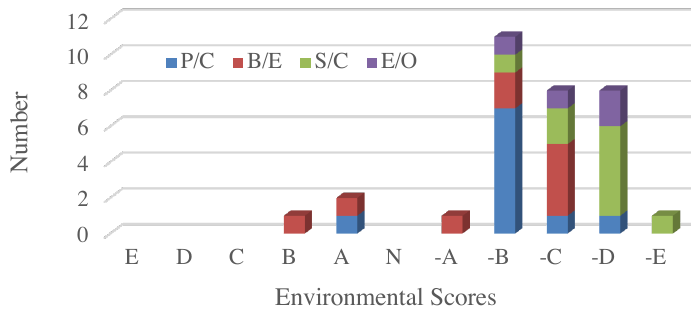
Figure 9. Environmental Impact Assessment of marginalized in